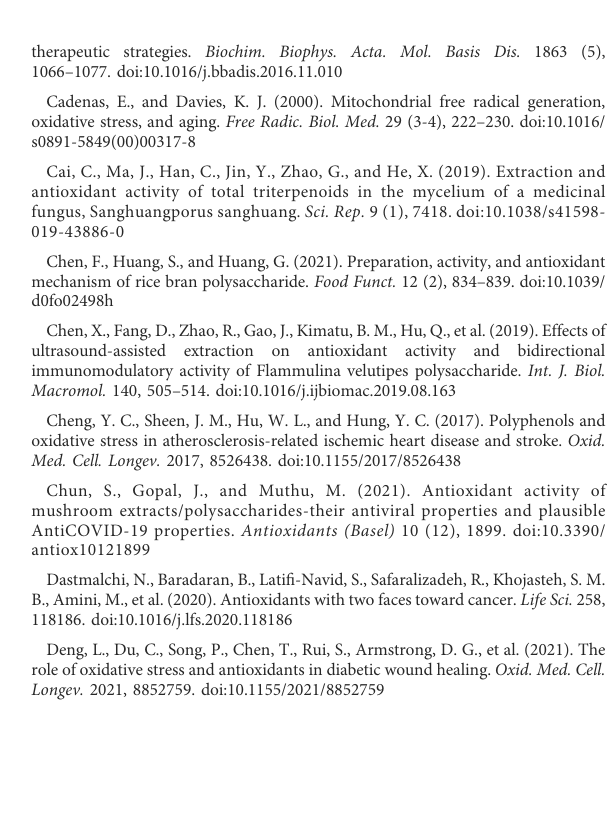
SUPPLEMENTARY FIGURE S1 Structureofcompoundspuri fi edfrommushrooms,withhydrogenatoms in red as active sites against oxidative stress. N is the number of cycles. (A) Structure of mushroom polysaccharide. (B) Structure of mushroom peptides. (C) Structure of mushroom polyphenols, with fl avonoids as an